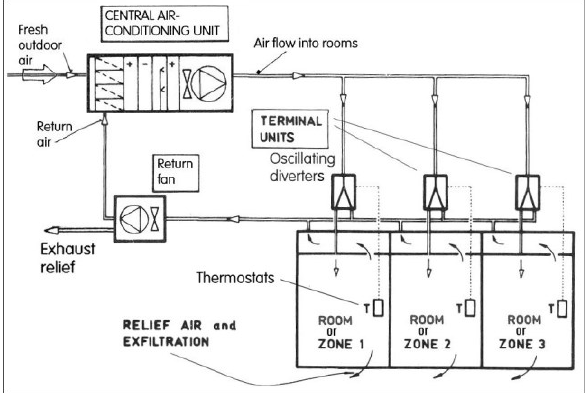
Fig. 16. Schematic representation of an all-air temperature control system with oscillating bistable diverter valves in the terminal units, operating in variable air-flow pulse-width mode. The ducts for diverted air are here combined with the ductwork for return air from